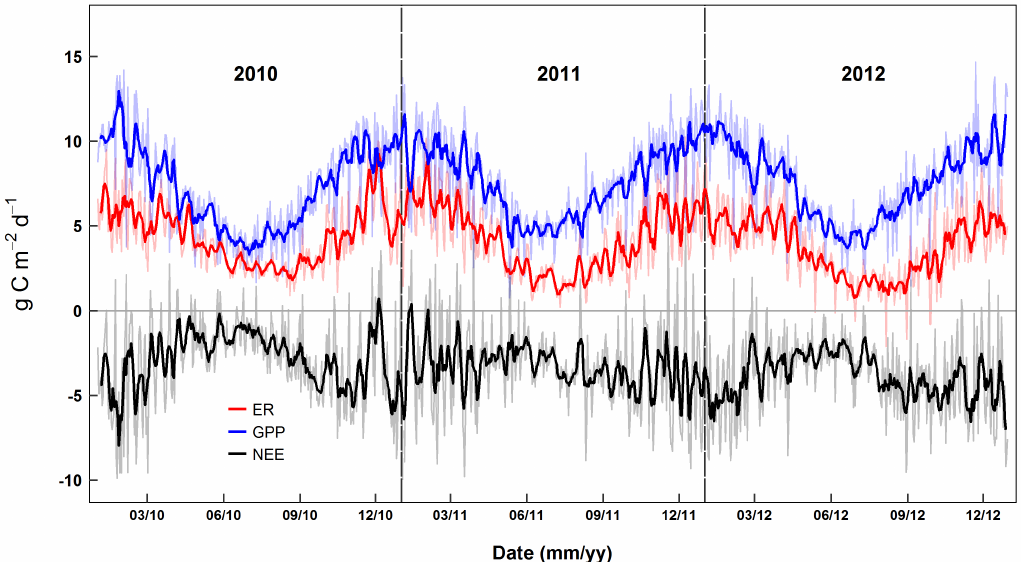
Figure 3. Ecosystem carbon fluxes of the Wombat State forest OzFlux site from 2010 to 2012: ecosystem respiration (ER, red lines), gross primary productivity (GPP, blue lines) and net ecosystem carbon exchange (NEE, black lines). Displayed is the output of the DINGO partitioning method (2a) using the night-time data approach with NN and early evening hours with daily totals (gCm − 2 d − 1 ) of ecosystem carbon fluxes (shaded lines) and 7-day running means of daily totals (bold lines) for better